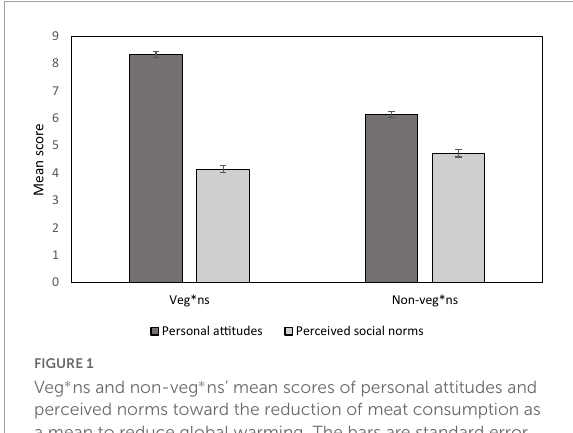
FIGURE1 Veg ∗ ns and non-veg ∗ ns’ mean scores of personal attitudes and perceived norms toward the reduction of meat consumption as a mean to reduce global warming. The bars are standard error